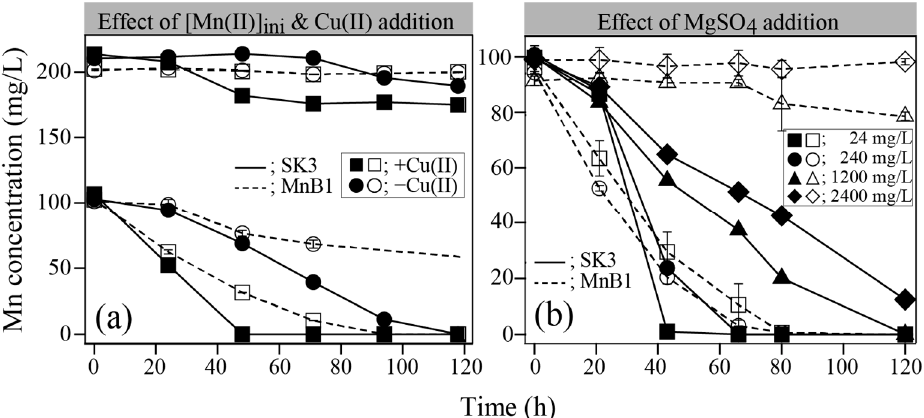
Figure 5. Mn(II) oxidative removal by isolate SK3 (solid symbols with solid lines) in comparison with Ps. putida MnB1 (open symbols with broken lines) under different conditions (pH ini 7.0, 25 °C). ( a ) Effects of the initial Mn(II) concentration (100 or 200 mg/L) was tested in the presence ( ■ , □ ) or absence ( ● , ○ ) of 3 μ M Cu(II). [MgSO 4 ] = 24 mg/L (present originally in PYG-1 medium). ( b ) Effects of increasing dose of MgSO 4 was tested by adding extra MgSO 4 to a fi nal concentration of 240 mg/L ( ● , ○ ), 1200 mg/L ( ▲ , △ ) or 2400 mg/L ( ♦ , ◇ ), in comparison with the controls ( ■ , □ ; 24 mg/L MgSO 4 originally present in PYG-1 medium). [Mn 2+ ] = 100 mg/L. [Cu(II)] = 3 μ M.